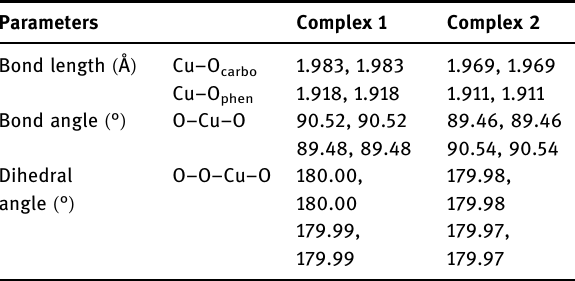
Table 2: Selective bond parameters of optimized structures